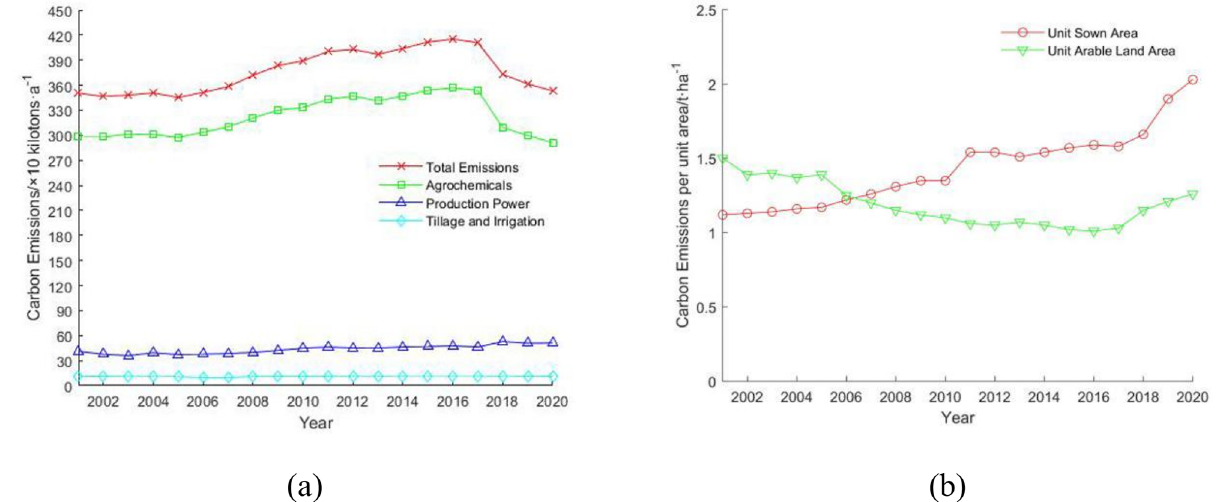
Figure 1. ( a ) Inter-annual variation of carbon emissions from farmland ecosystems in Guangdong; ( b ) inter- annual variation in carbon emissions per unit area of farmland ecosystems in